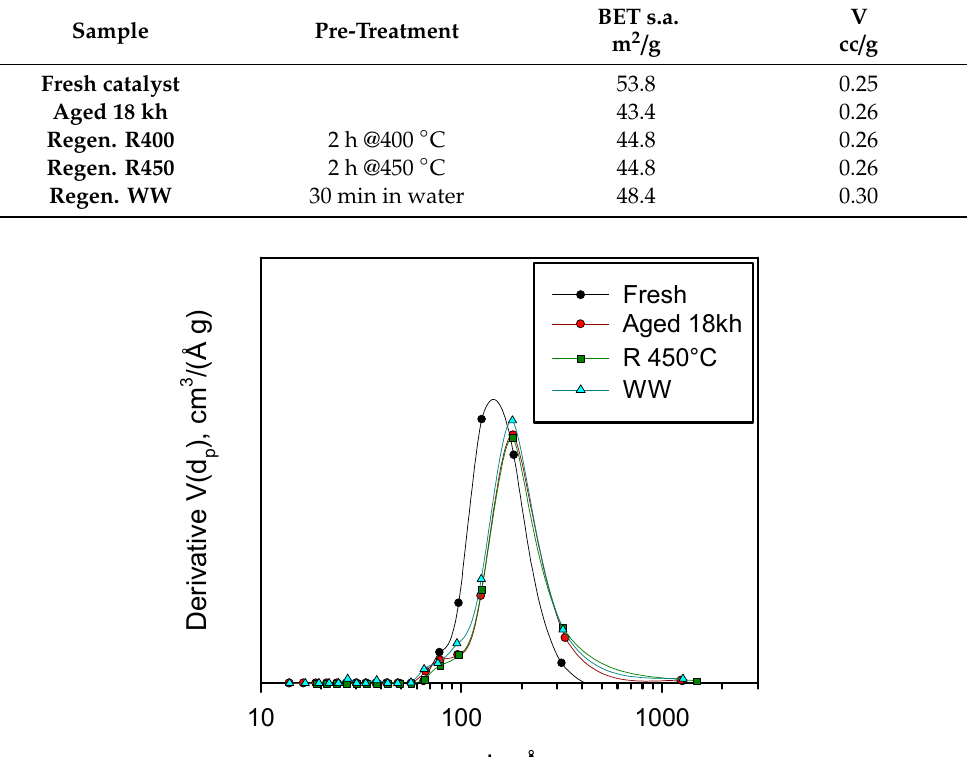
Figure 1. Pore size distribution for fresh, aged, and regenerated catalysts by heat treatment (R 450 °C) or washed in water (WW). Table 2. BET surface area and volume of pores of fresh, aged and regenerated selective catalytic reduction (SCR) catalysts.